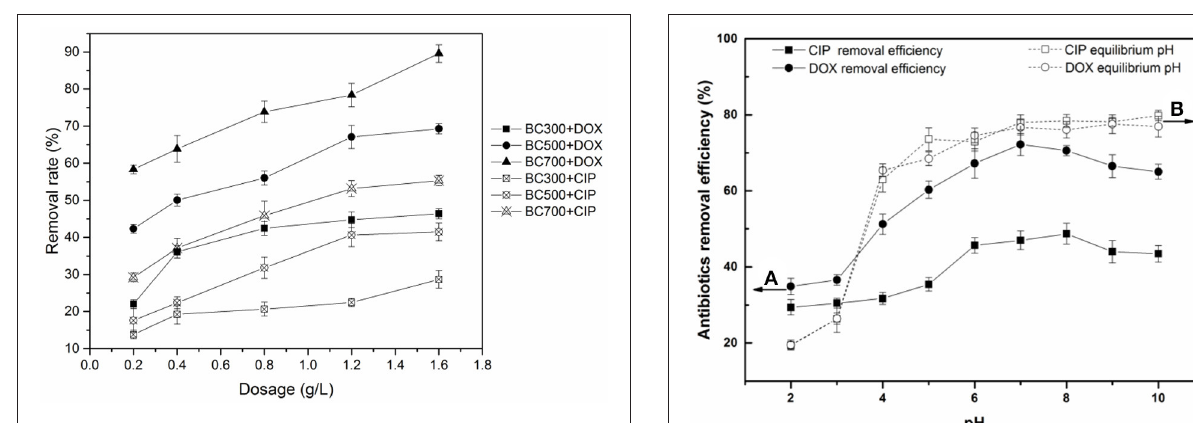
FIGURE 1 | Effect of biochar dosage on the adsorption of DOX and CIP by BC300, BC500, and BC700 (initial concentration = 20 mg/L; temperature = 298K; pH = 6; contact time = 24h).